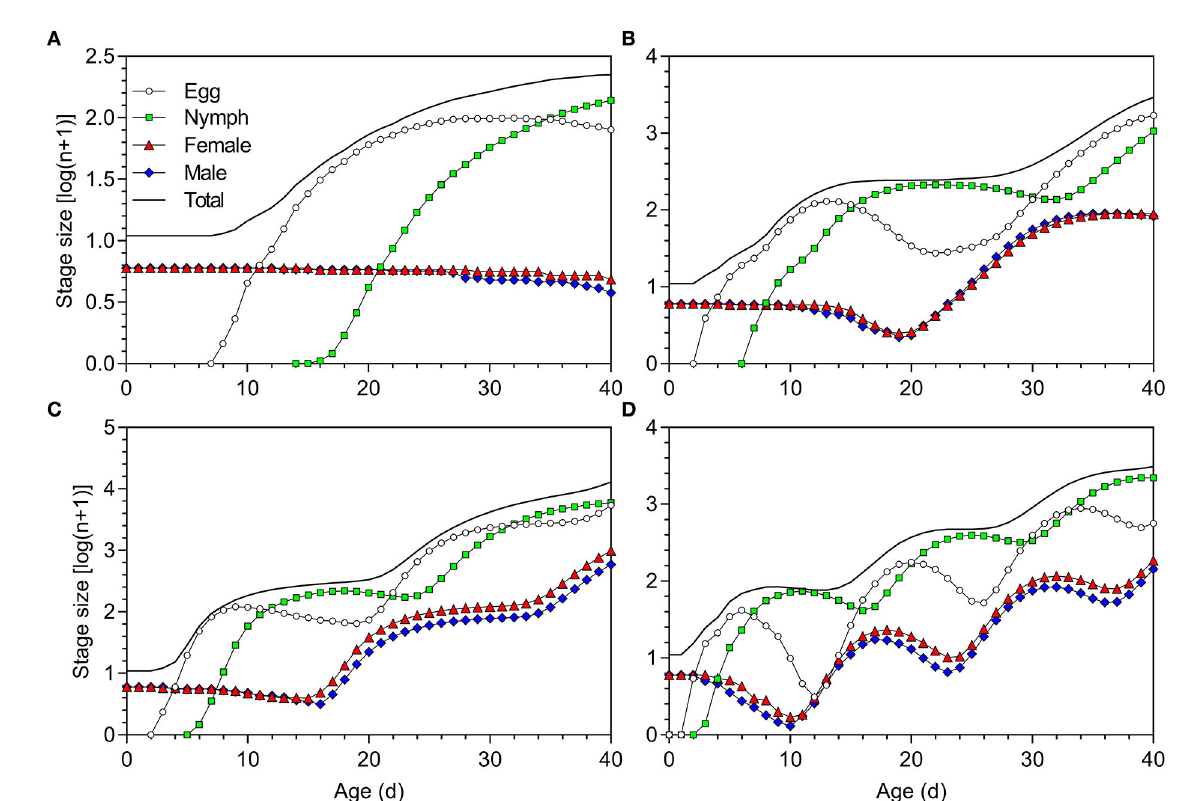
FIGURE7 Population projection of Orius strigicollis fed on Frankliniella occidentalis at (A) 18.5 ◦ C, (B) 23.5 ◦ C, (C) 27 ◦ C, and (D) 33 ◦ C starting with an initial population of five paired